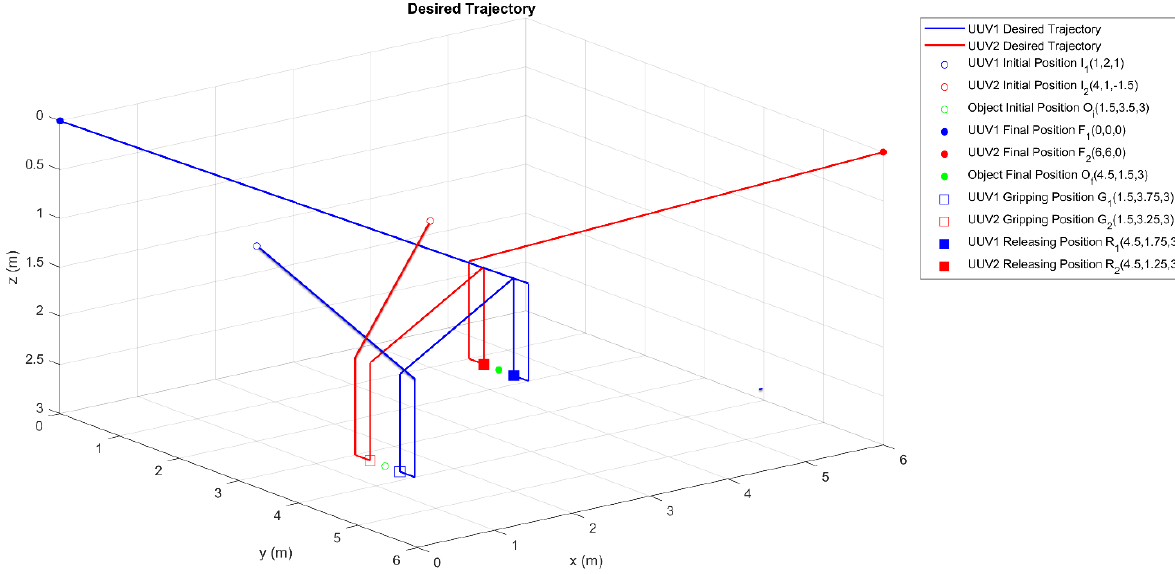
Figure 4. Collaborative manipulation task. Trajectory design for both BlueROV2 vehicles.